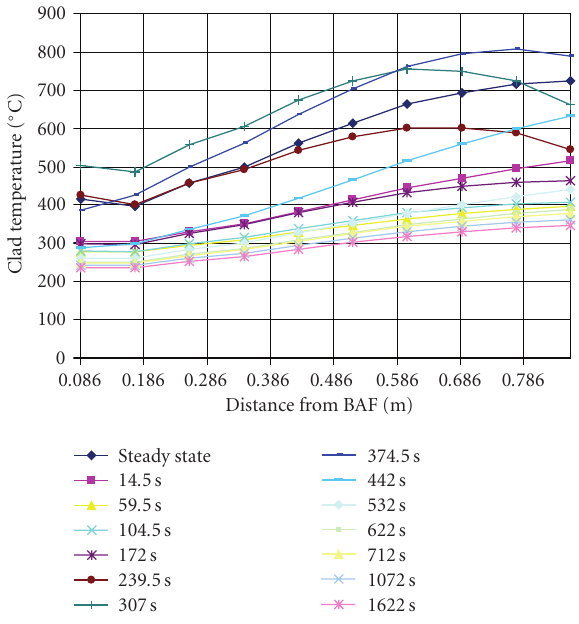
Figure 18: Temperature axial profile—LOFA—Hot Channel.